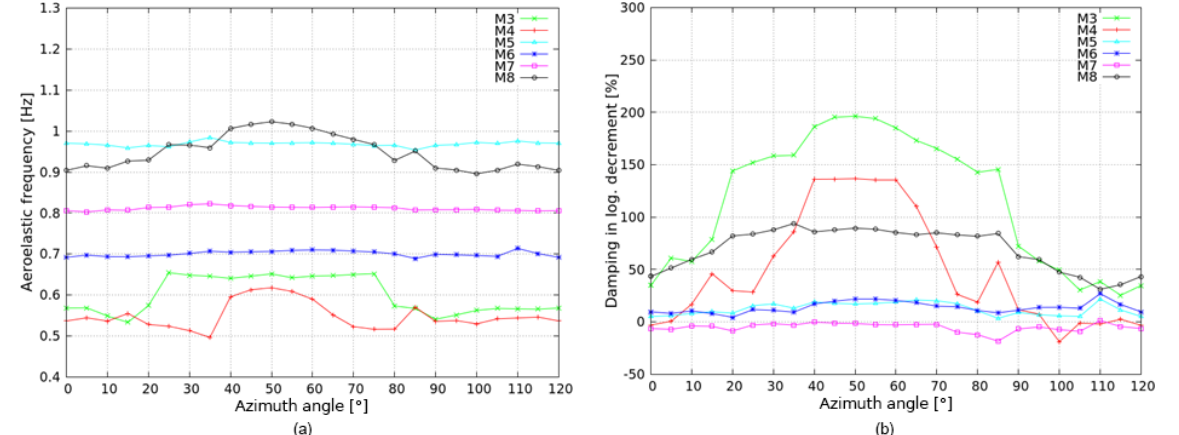
Figure 19. (a) Modal frequency and (b) modal damping of rotor modes versus azimuth angle at U = 42 . 5ms − 1 and yaw = 30 ◦ (unsteady aerodynamics based on the ONERA model).